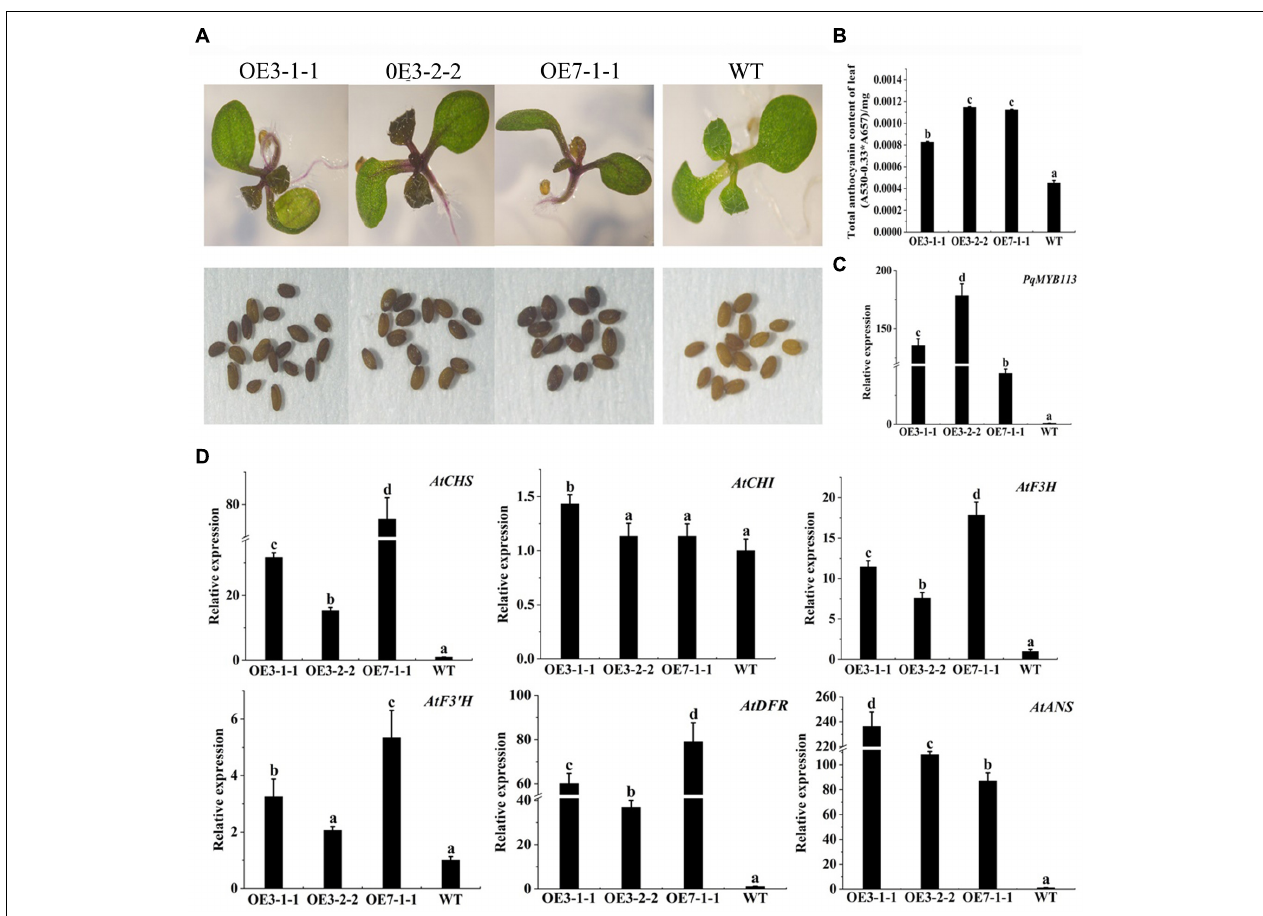
FIGURE 6 | The phenotype and the effect of PqMYB113 overexpression in transgenic Arabidopsis plants. (A) The seeding and seeds phenotype of transgenic overexpression lines OE 3-1-1, OE 3-2-1, and OE 7-1-1 in comparison to WT. Arabidopsis seedlings were grown on MS plates at 22 ◦ C for 10 days. (B) The anthocyanin content in leaves. (C) The expression level of PqMYB113 gene in leaves. (D) The expression level of anthocyanin biosynthesis structure genes in leaves. a, b, c, and d indicate significant differences at the P ≤ 0.05 level by Duncan’s